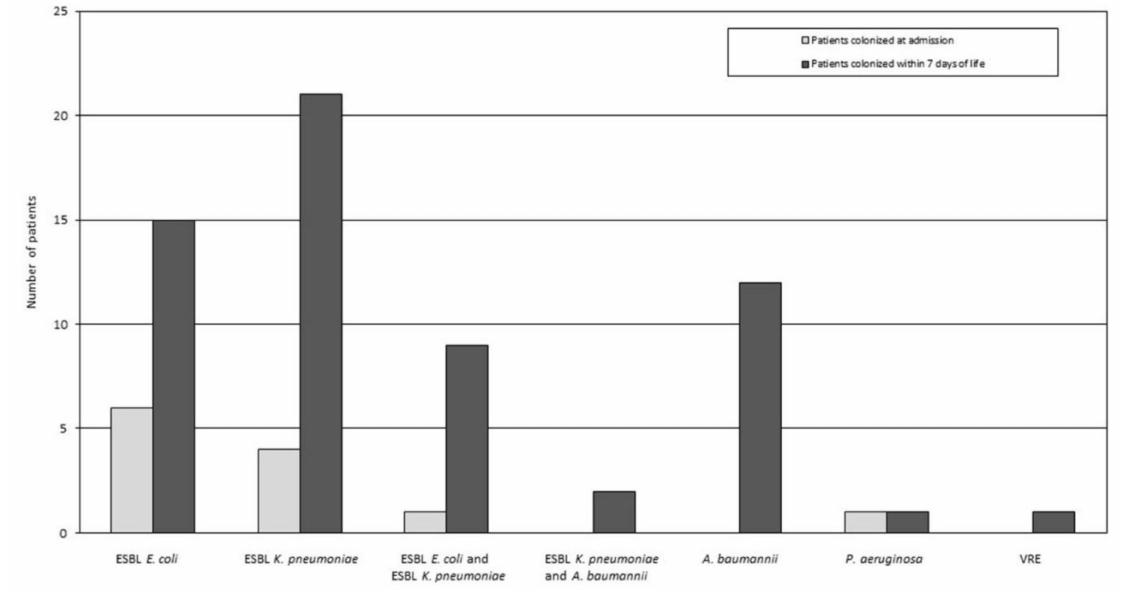
Figure 1. Distribution of gut colonizing multidrug-resistant (MDR) bacteria detected in preterm neonates at admission and within the first seven days of